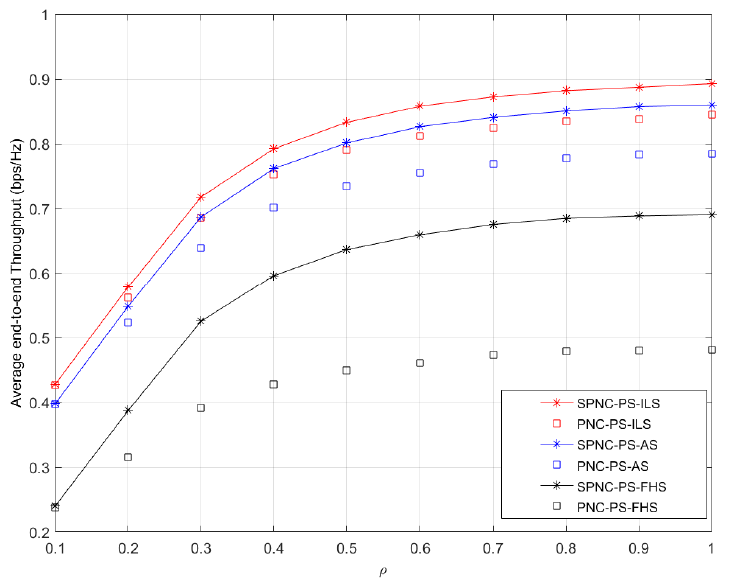
Figure 6. Average end-to-end throughput performance versus different PS coefficients ρ in PS aided two-way satellite-terrestrial relay network with ILS, AS, and FHS.